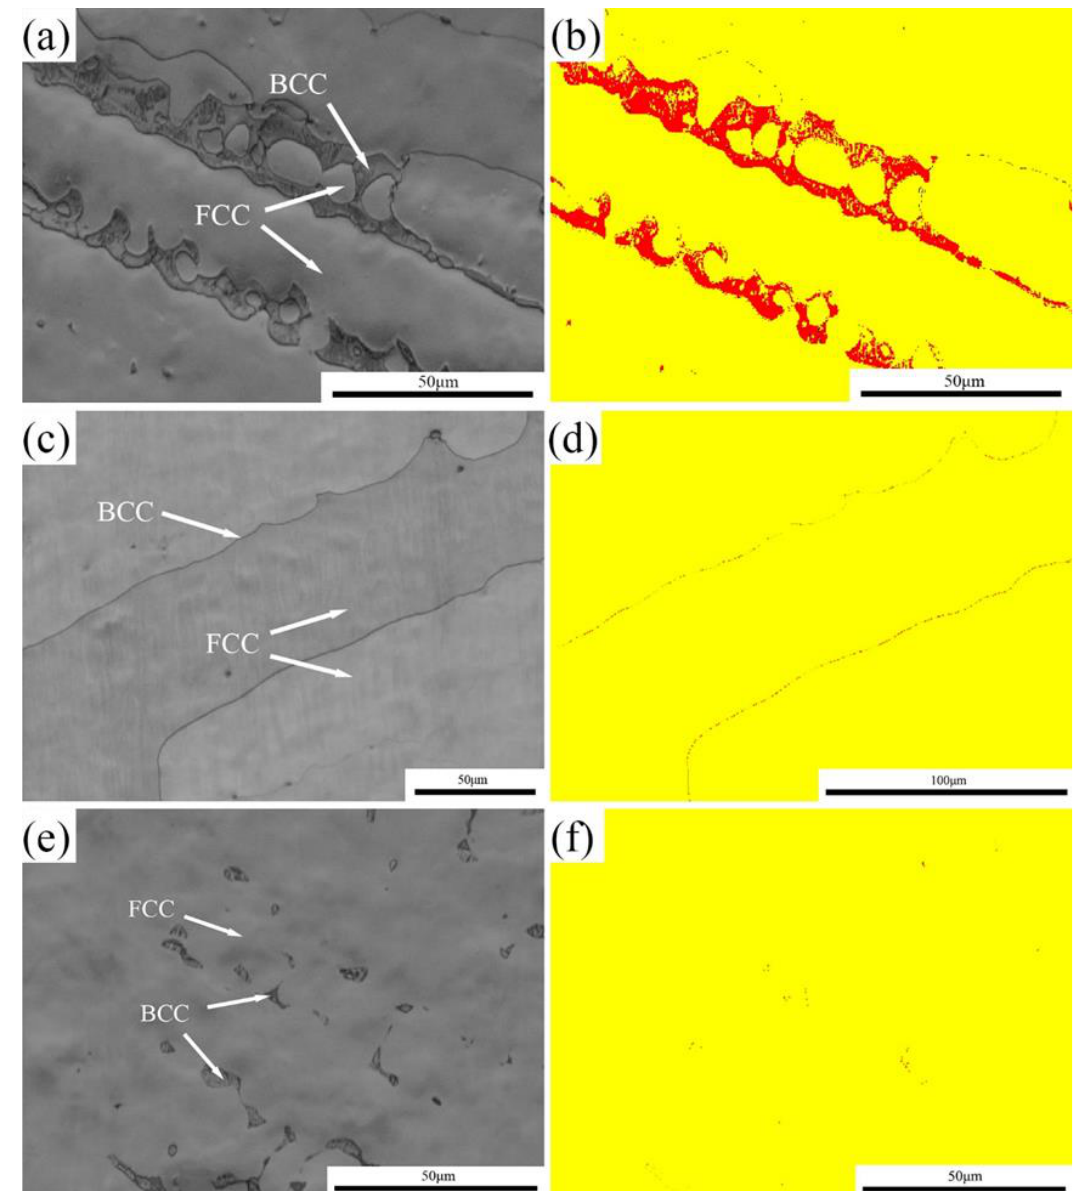
Figure 3. EBSD BC and phase images of the as-cast alloy samples. ( a , c , e ) are BC images for B0.5, Mg0.5, and Zr0.5 HEAs, respectively; ( b , d , f ) are the phase images of B0.5, Mg0.5, and Zr0.5 HEAs,